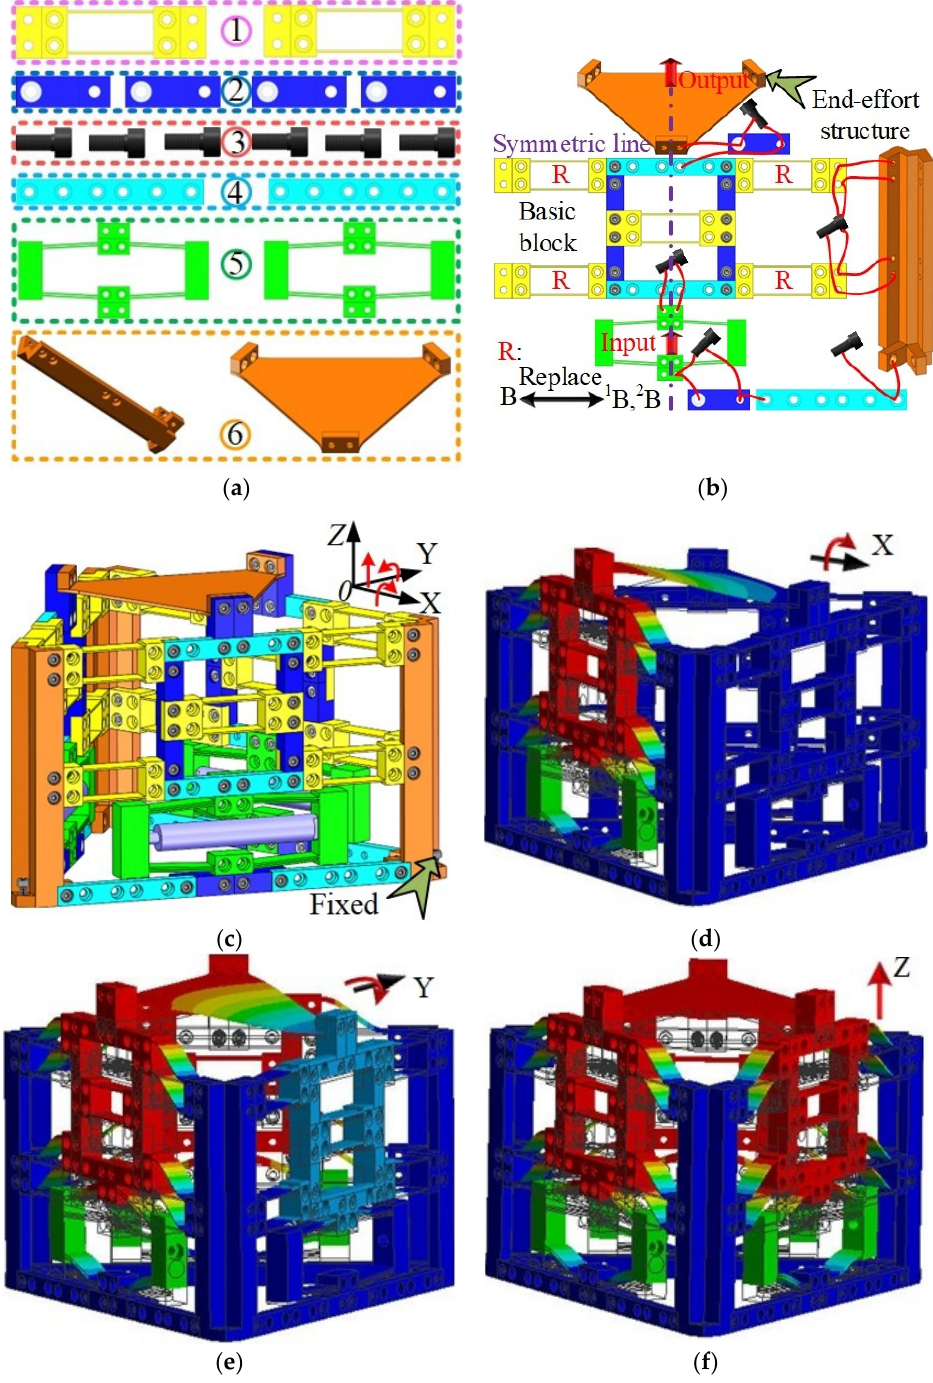
Figure 11. Flexure-based Z θ × θ y MPS: ( a ) module library; ( b ) assembly of modules; ( c ) display of the 3D model of flexure-based Z θ × θ y MPS; ( d – f ) simulation results. 1, transmission modules; 2, Z-type connection modules; 3, bolts; 4, I-type connection modules; 5, amplification modules; 6, column and triangular custom